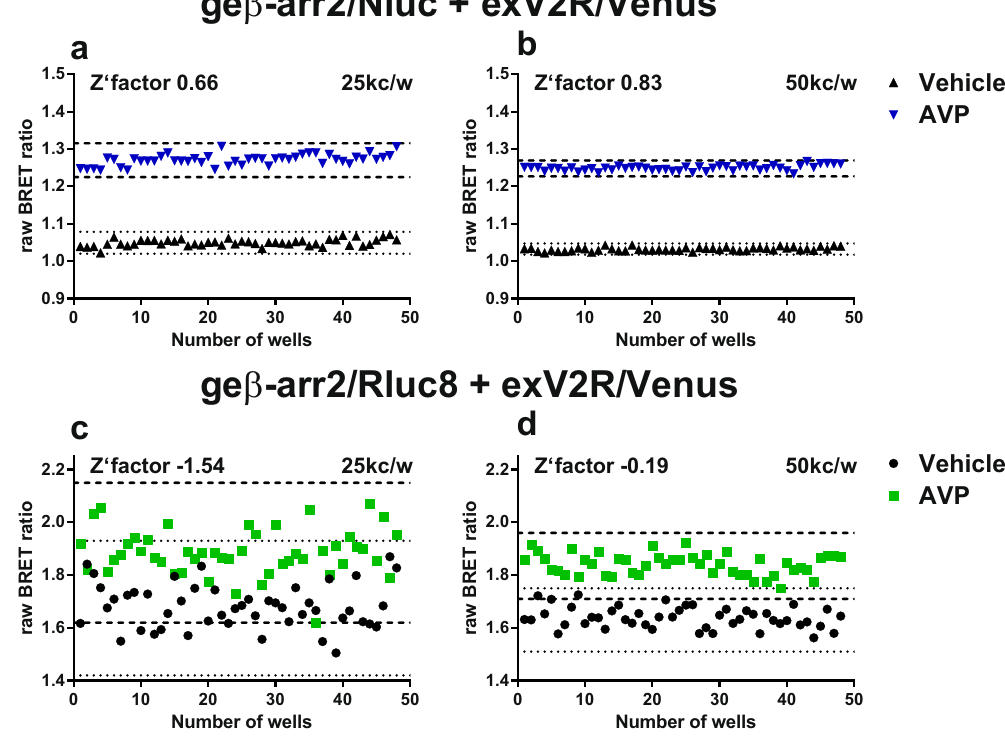
Figure 3. Determining luciferase and assay sensitivity by Z ′ factor calculation. HEK293FT cells expressing genome-edited β -arrestin2 fused to Nluc ( a , b , ge β -arr2/Nluc) or Rluc8 ( c , d , ge β -arr2/Rluc8) were transiently transfected with cDNA coding for V2R fused to Venus (exV2R/Venus) and used to calculate Z ′ factors. Cells seeded at 25,000 cells/well (25kc/w; a , c ) or 50,000 cells/well (50kc/w; b , d ) were treated with vehicle (black symbols) or AVP (1 µ M; blue triangles, green squares). Points represent raw BRET ratio of individual wells ~25 minutes following vehicle or AVP addition. Dashed and dotted lines indicate 3 standard deviations (SD) from the mean of the AVP-treated and vehicle-treated data sets respectively. Z ′ factors are calculated as described in Methods . Data shown are representative of three independent